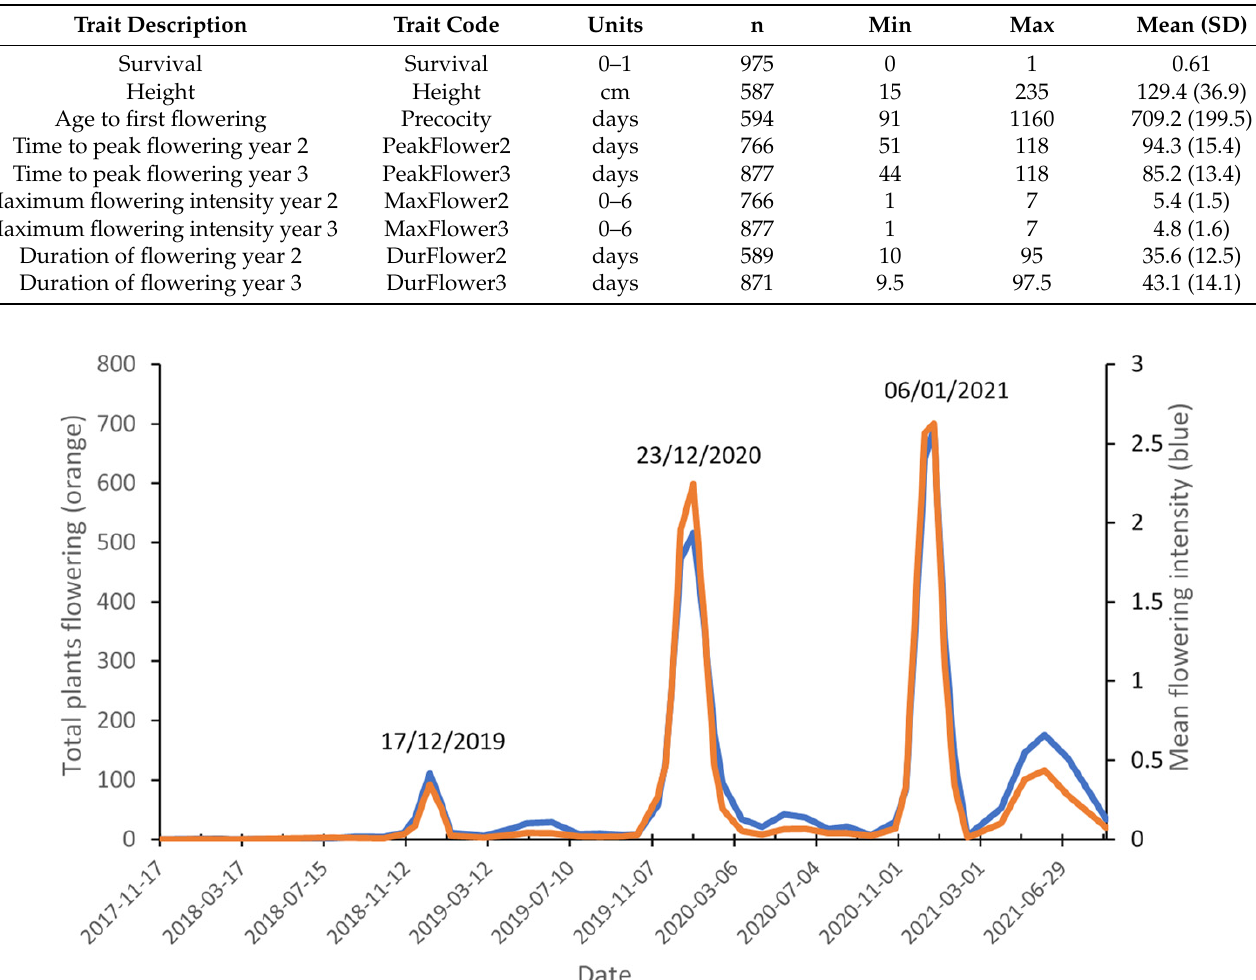
Table 1. Trait codes and descriptive statistics for all Leptospermum scoparium plant traits studied. The survival, height, and precocity data are only for the original planting, whereas the flowering peak and durational data included replants.